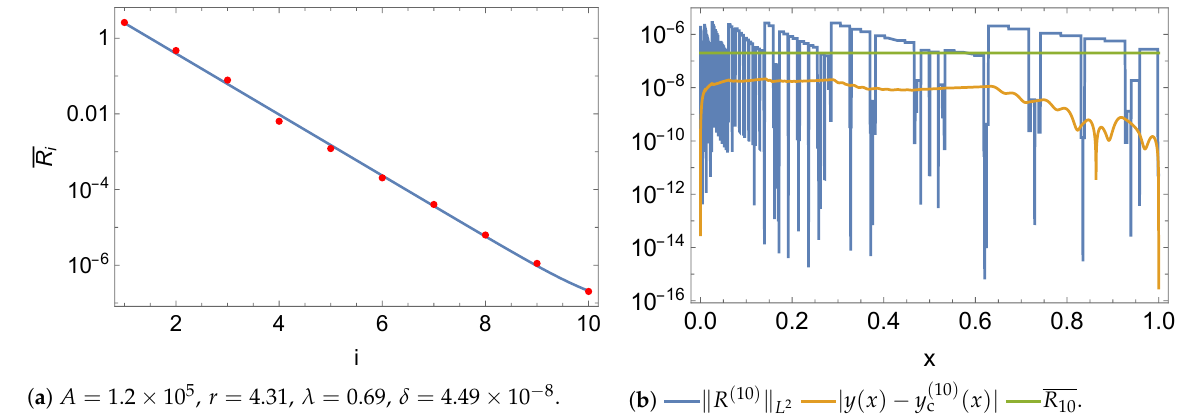
Figure 6. ( a ) Fitting the upper bound (24) with the set R . ( b ) Visualization of the residual, absolute local approximation error, and the mean